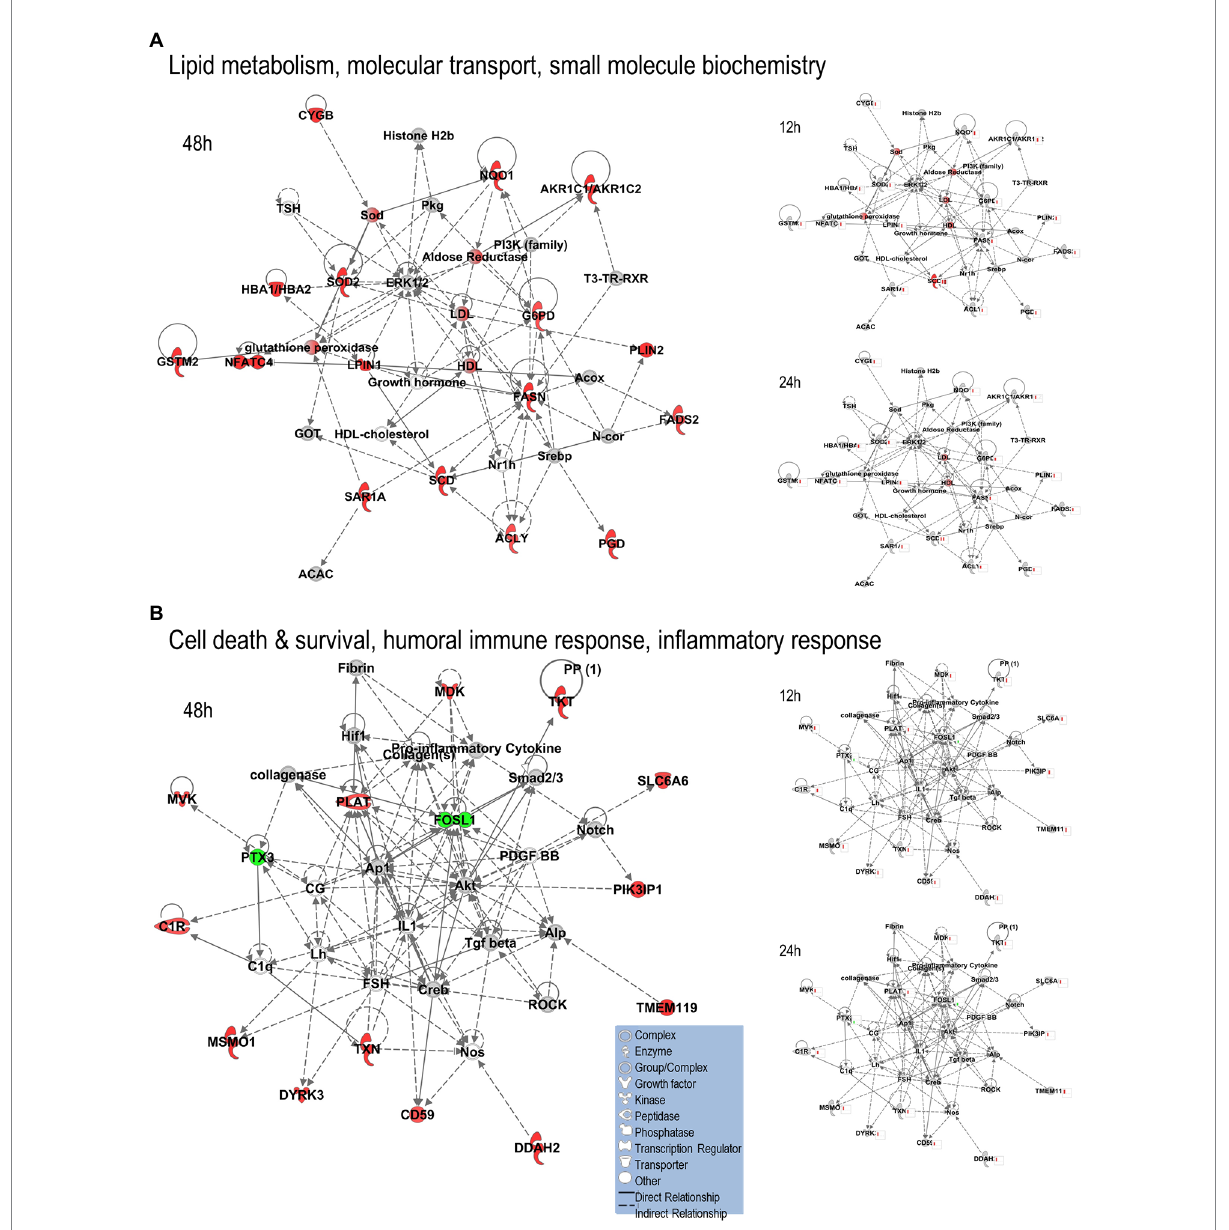
FIGURE 4 Top MRC-5 pathways affected by OC43 infection at 48 hpi. Proteins and their levels of dysregulation were uploaded into Ingenuity Pathway Analysis (IPA) and top pathways constructed. (A) The “lipid metabolism, molecular transport, and small molecule biochemistry” network. (B) The “cell death and survival, humoral immune response, and inflammatory response” network. Only the top two networks are shown. Additional networks, and their associated proteins, are listed in Supplementary Table S1. Protein levels at 12 and 24 hpi were overlaid onto these pathways (smaller diagrams at right). Upregulated proteins depicted in red, downregulated in green, insignificantly regulated in gray, direct interactions shown with solid lines, and indirect interactions depicted with dashed lines. Molecular types as indicated in